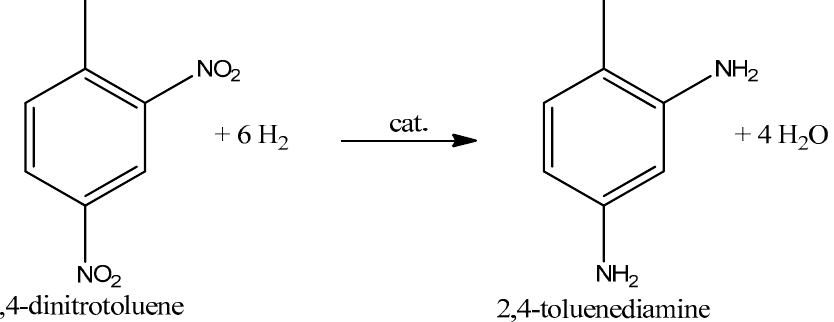
Figure 3. General reaction equation with the main 2,4 isomer [27] .